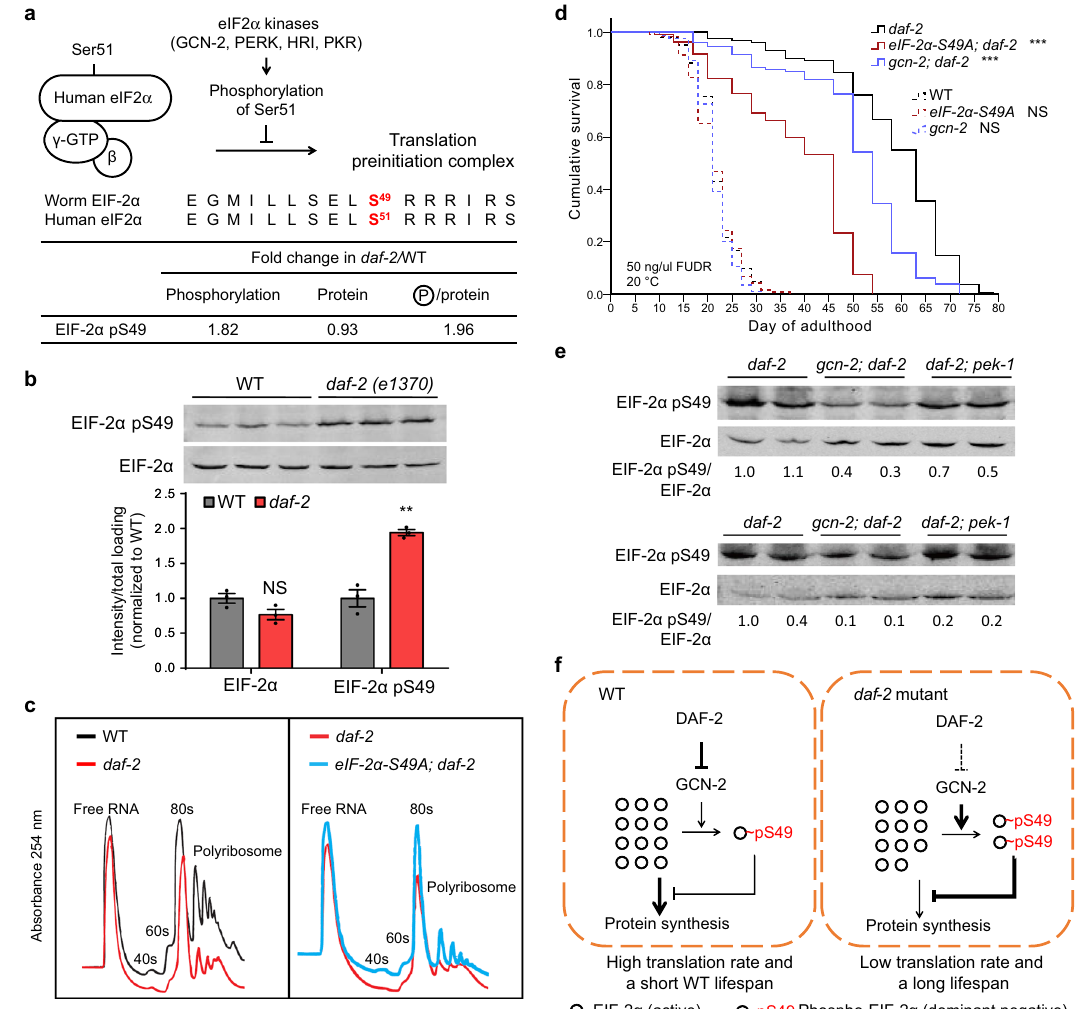
Fig. 4 EIF-2 α pS49 is a potent regulator of translation and lifespan in daf-2 . a Phosphoproteomics data showed that EIF-2 α S49, corresponding to human eIF2 α S51, is hyper-phosphorylated in the daf-2 mutant. Model illustrates that phosphorylation on the α -subunit of human eIF2 by kinases including GCN-2, PERK, HRI, and PKR prevents the formation of translation preinitiation complex and results in repression of global protein synthesis. b Immunoblotting analysis con fi rmed the hyper-phosphorylation on EIF-2 α S49 in the adult day 1 daf-2(e1370) worms. WT or daf-2 worm lysates were immunoblotted with a phospho-speci fi c antibody that recognizes EIF-2 α pS49 or with an antibody speci fi c to the EIF-2 α total protein. NS p = 0.085, ** p = 0.0019, n = 3 technical replicates, two-tailed Student ’ s t test, error bars denote the SEM. See biological replicates in Source data. c Polyribosome pro fi les of the WT, daf-2(e1370) , or eif-2 α -S49A(hqKi188); daf-2(e1370) worms harvested at adult day 1. hqKi188 was generated using CRISPR/Cas9 technology. Worm lysates with the same amount of total proteins were separated by sucrose gradient centrifugation and analyzed with the absorbance recording at OD 254 nm. See biological replicates in Source data. d Phosphorylation of EIF-2 α S49 contributes to daf-2 longevity. eif-2 α -S49A(hqKi188) mutation and EIF-2 α kinase mutation gcn-2 (ok886) signi fi cantly shortened the lifespan of the daf-2(e1370) worms but did not disturb the WT lifespan. *** p < 0.001, NS not signi fi cant, two-sided log- rank test, n > 80 worms per strain. Lifespan assays were performed at 20 °C, with 50 ng/ μ l FUdR supplied in plates. See statistics and the FUdR-free results in Supplementary Data 4. e Immunoblotting showing the level of EIF-2 α pS49 and EIF-2 α total protein in the daf-2(e1370) , gcn-2(ok886); daf-2(e1370) , or daf-2(e1370); pek-1(ok275) mutants harvested at adult day 1. The ratios of EIF-2 α pS49 intensity, normalized to the EIF-2 α total protein level, are presented below. n = 2 independent experiments. In both trials, through comparing to daf-2 , EIF-2 α pS49 was markedly decreased in gcn-2; daf-2 but mildly reduced in daf-2; pek-1 . f A model illustrates that IIS regulates EIF-2 α S49 phosphorylation through GCN-2. EIF-2 α pS49 potently inhibits protein synthesis and contributes substantially to daf-2